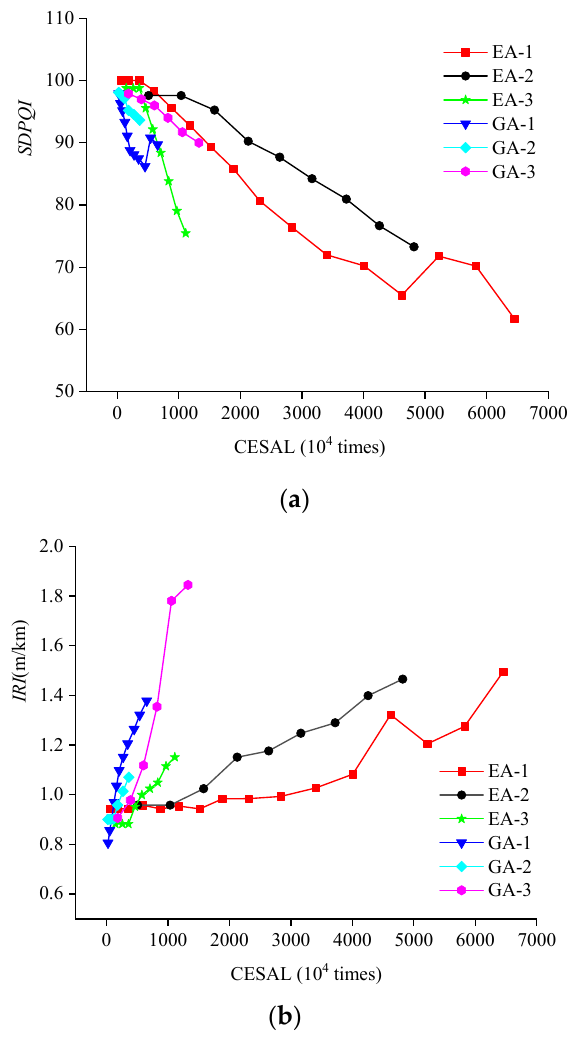
Figure 2. Life-cycle performance index data of the investigation sample: ( a ) SDPQI ; ( b ) IRI ; CESAL = cumulative equivalent single axle loads; SDPQI = performance index of SBDPS; IRI = international roughness index.